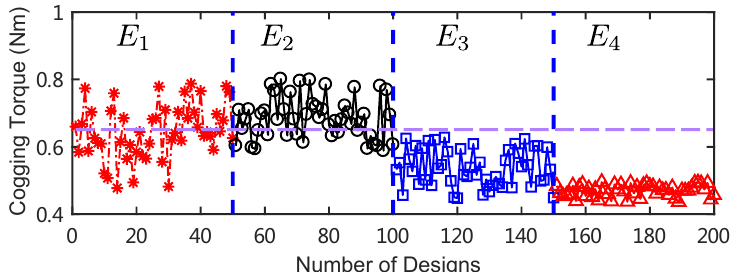
Figure 8. Peak-to-peak Cogging torque performance under different assembling methods E 1 to E 4 .